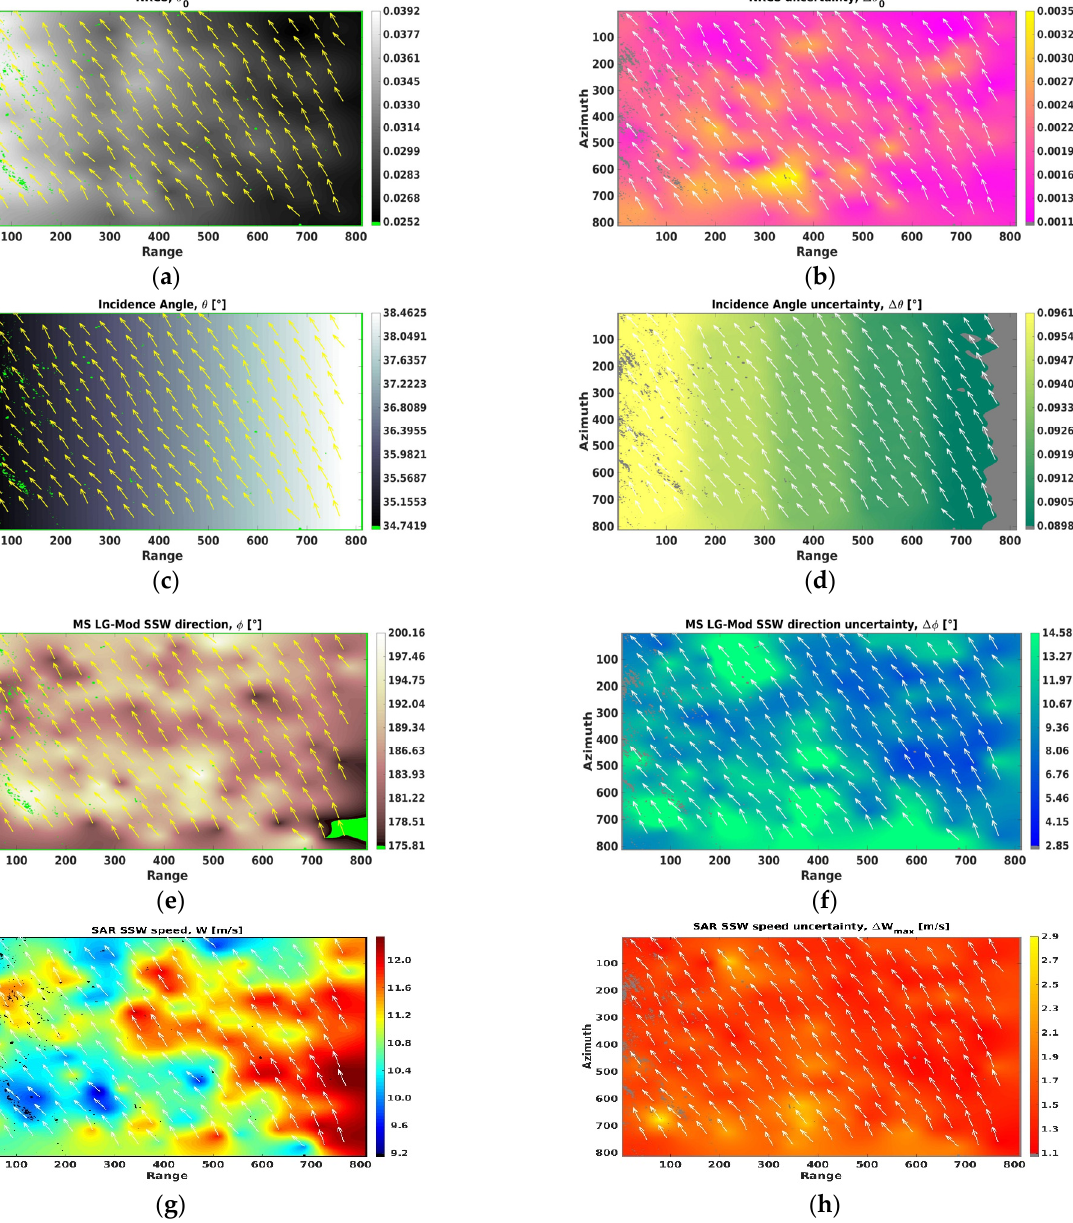
Figure 6. SAR NRCS σ 0 ( a ), incidence angle θ (°) ( c ), MS LG-Mod SSW direction φ (°) ( e ) and CMOD5.N-derived SSW speed W (m/s) ( g ), with their uncertainties Δσ 0 ( b ), Δθ (°) ( d ), Δφ (°) ( f ) and Δ W max (m/s) ( h ), respectively. All maps are obtained at 5 km by 5 km from a Sentinel-1 IW image, ascending, VV-polarised, acquired on 16th May 2018 at 17:33:28 UTC. Estimated SSW vectors are superimposed.